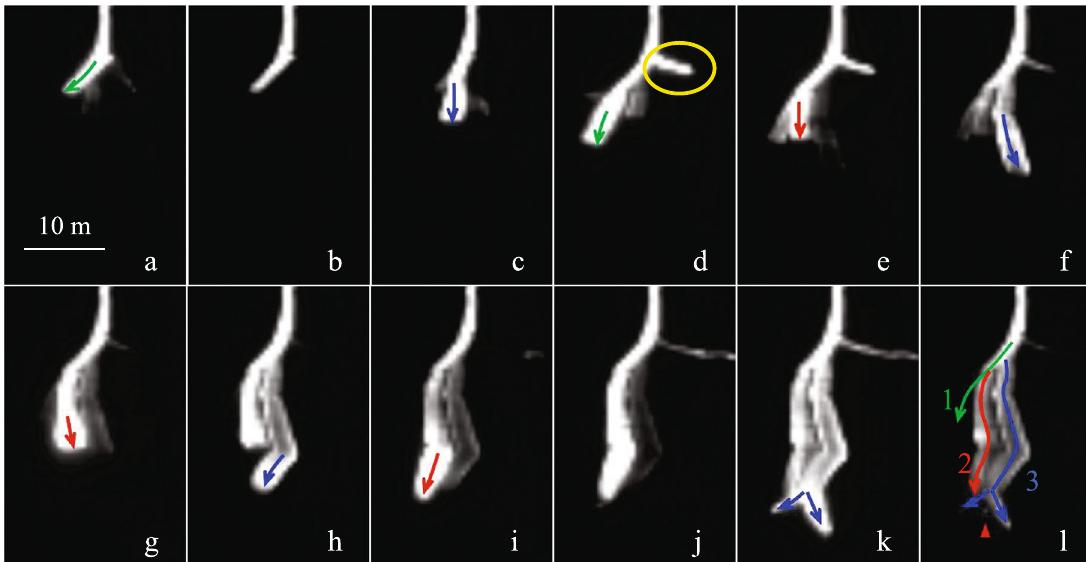
Figure 3. Consecutive frames for Flash #1 illustrating the alternate stepping of the branches sharing a root. The green, red and blue arrowed curves indicate the stepped development of branches 1, 2 and 3,